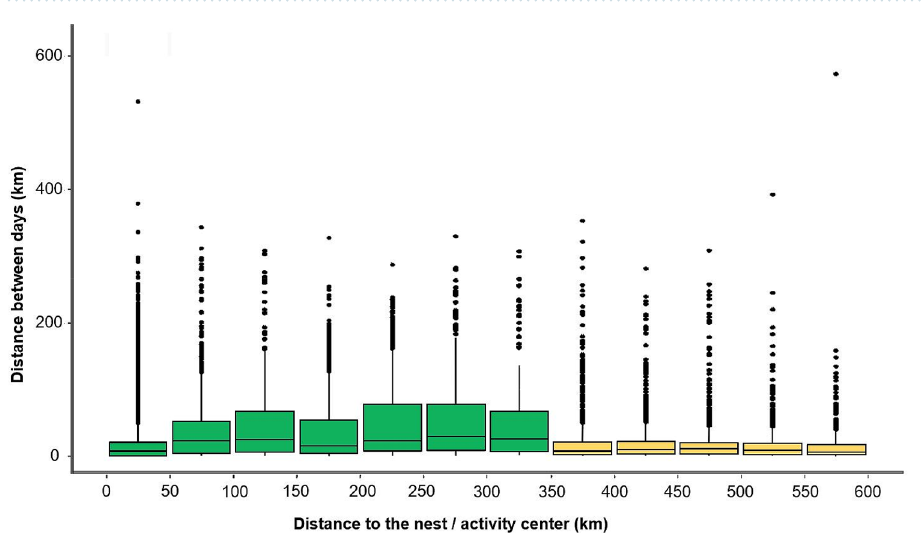
Figure 2. Daily distance travelled by GPS-tagged Eurasian griffon vultures. We show Euclidean distances (in km) between locations of the GPS-tagged birds (all pooled) in consecutive days (from day t to day t+1 ) in relation to the distance from the location of the day t+1 to the nest or activity center. Colors show categories (< 350 km or > 350 km) used in the modelling